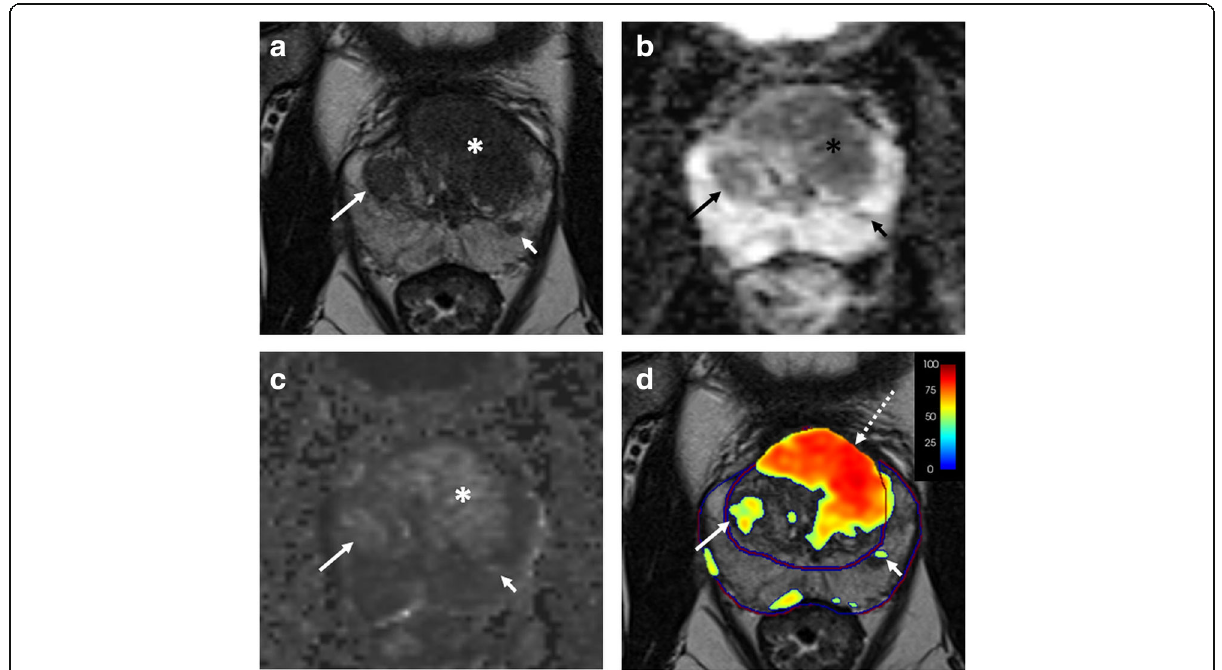
Fig. 5 A 66-year-old man with a serum PSA of 14.3 ng/mL. Axial T2-weighted imaging ( a ), ADC map ( b ), and calculated b = 1500 s/mm 2 image ( c ) showed a lesion in the left mid TZ (asterisk in a , b , c ). In addition, note a BPH nodule in the right mid TZ (long arrow in a , b , c ) and an ectopic BPH nodule in the left mid PZ (short arrow in a , b , c ). Computer-aided diagnosis map overlaid on the T2-weighted image ( d ) showed a high cancer probability within the left mid TZ lesion (dashed arrow), whereas it showed low cancer probability within the right mid TZ BPH nodule (long arrow) and the ectopic BPH nodule in the left mid PZ (short arrow). Final pathology revealed a Gleason 7 (3 + 4) prostate cancer within the left mid TZ lesion (image courtesy of Dr. Baris Turkbey and Dr. Stephanie Harmon from Molecular Imaging Program, NCI, NIH, Bethesda, MD,